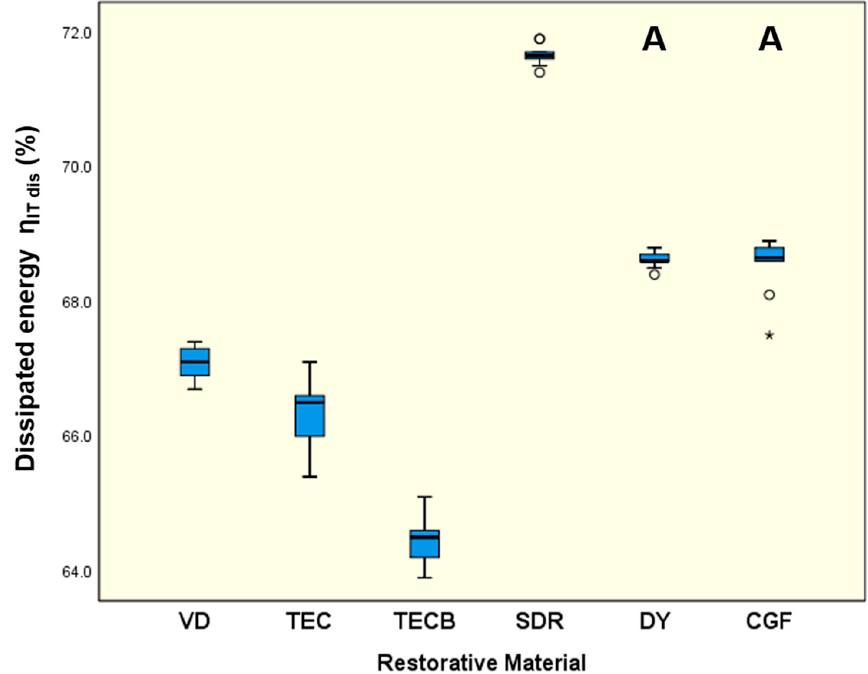
Figure 10. Plastic index of instrumented indentation testing ( η ITdis ) (%). Identical uppercase letters denote no significant difference among groups ( p > 0.05). Circles represent mild outliers (<3.0 × interquartile range) and asterisks extreme outliers (>3.0 × interquartile range).